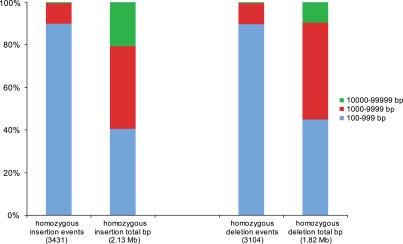
Number and Length Distribution of Apparent Homozygous Insertion and Deletion Sequences Greater than 100 bpNote that the number of indel events are similar but that there are more longer insertions than deletions.